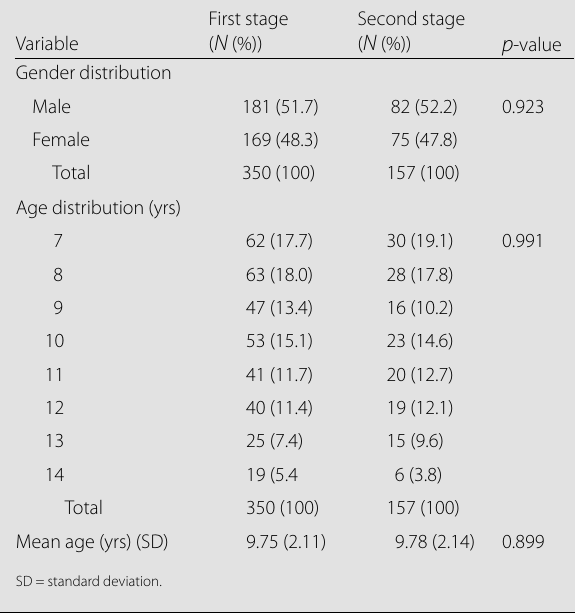
SD = standard deviation.